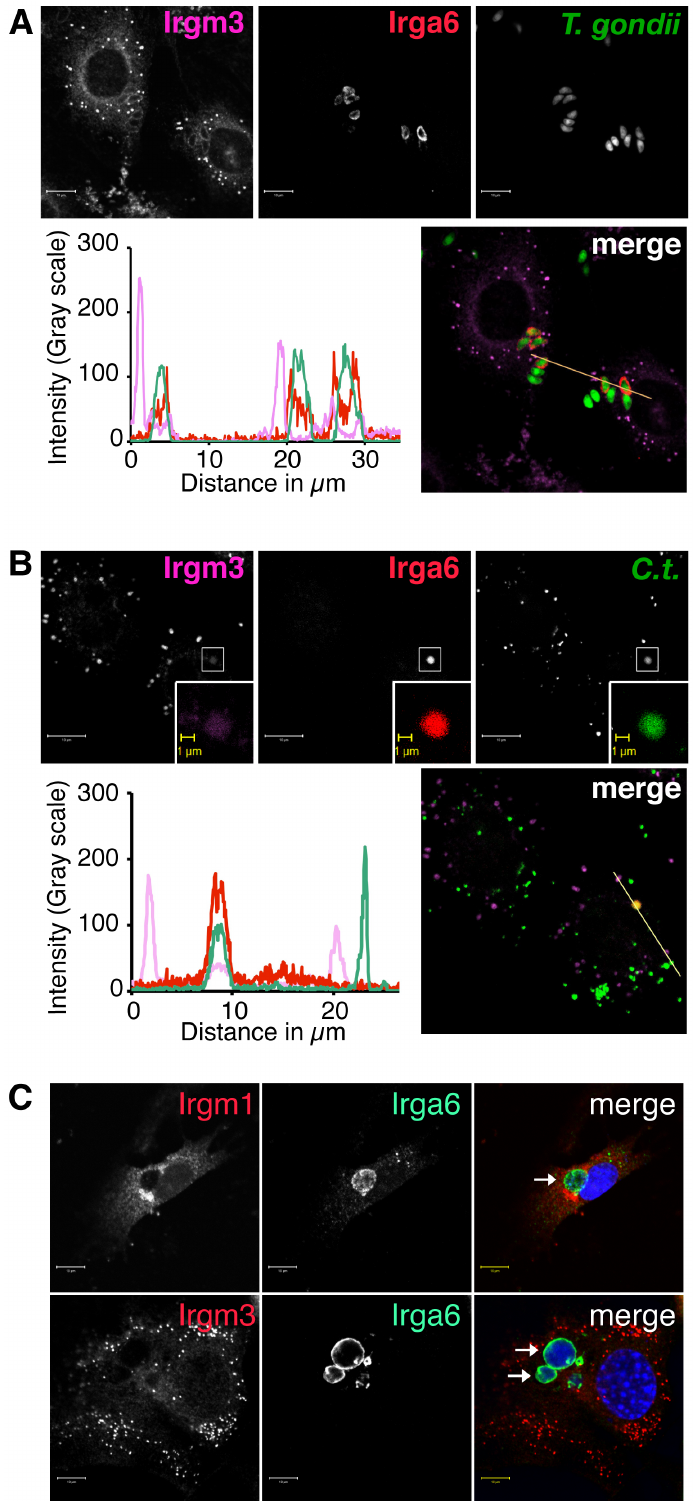
Figure 4. T.gondii PVs and C.trachomatis inclusions are largely devoid of Irgm1/m3. Images and line tracing of fluorescent intensity are shown. Data are representative of results obtained in at least 3 independent experiments conducted for each experimental design. ( A ). IFN c - activated MEFs were infected with GFP-expressing T. gondii and stained with an anti-Irga6 and anti-Irgm3 antibody. ( B ) IFN c -activated MEFs were infected with GFP-expressing C. trachomatis and stained with an anti-Irga6 and anti-Irgm3 antibody at 2 hpi. ( C ) MEFs were infected with C. trachomatis and activated with 100 U/ml of IFN c at 3 hpi. Cells were fixed at 20 hpi and stained with an anti-Irga6 antibody in combinations with either anti-Irgm1 or anti-Irgm3 antibodies and Hoechst. Whereas Irga6 co-localized with inclusions at the expected frequency of 10–15% (data not shown), no targeting of endogenous Irgm1 or Irgm3 to inclusions was observed in the course of examining the staining of more than one hundred randomly selected inclusions. Arrows point at inclusions. doi:10.1371/journal.ppat.1003414.g004 PLOS Pathogens |